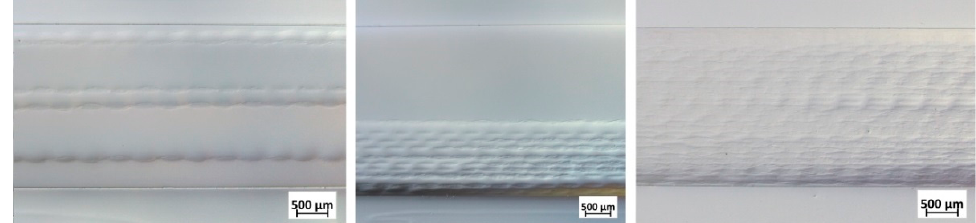
Figure 6. Light microscope images showing the cross-section of the composite samples manufac- tured via RTM with 5 ( left ), 10 ( middle ), and 29 layers ( right ) of E-glass fabric in a thermoset polymer matrix.